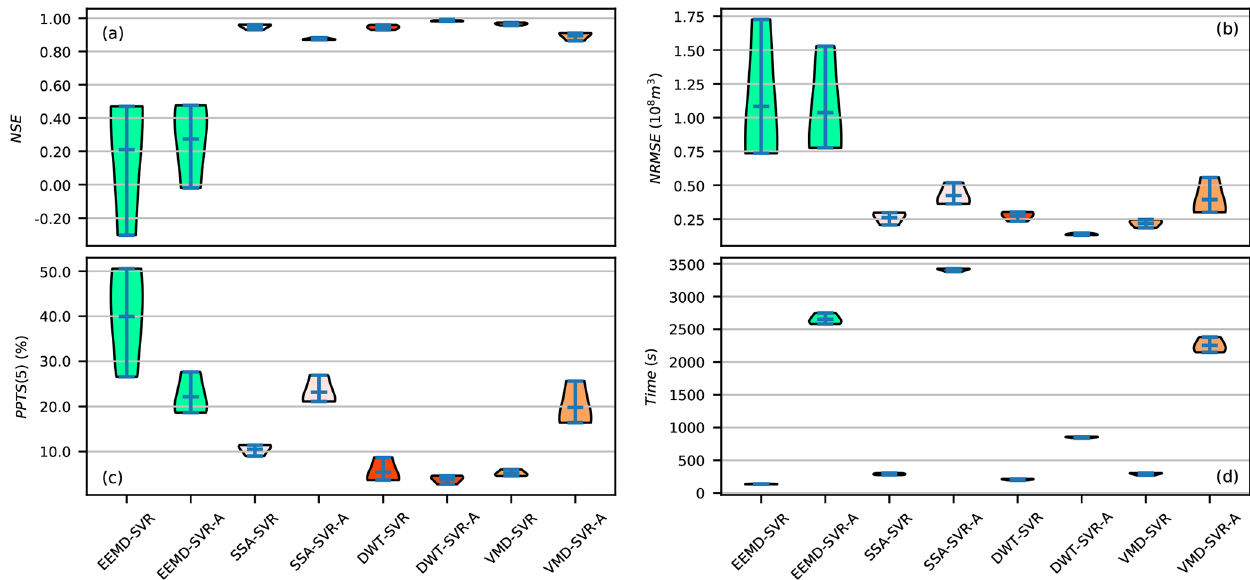
Figure 17. Violin plots of the evaluation criteria for 1-month-ahead runoff forecasting during the test phase of the TSDP and TSDE